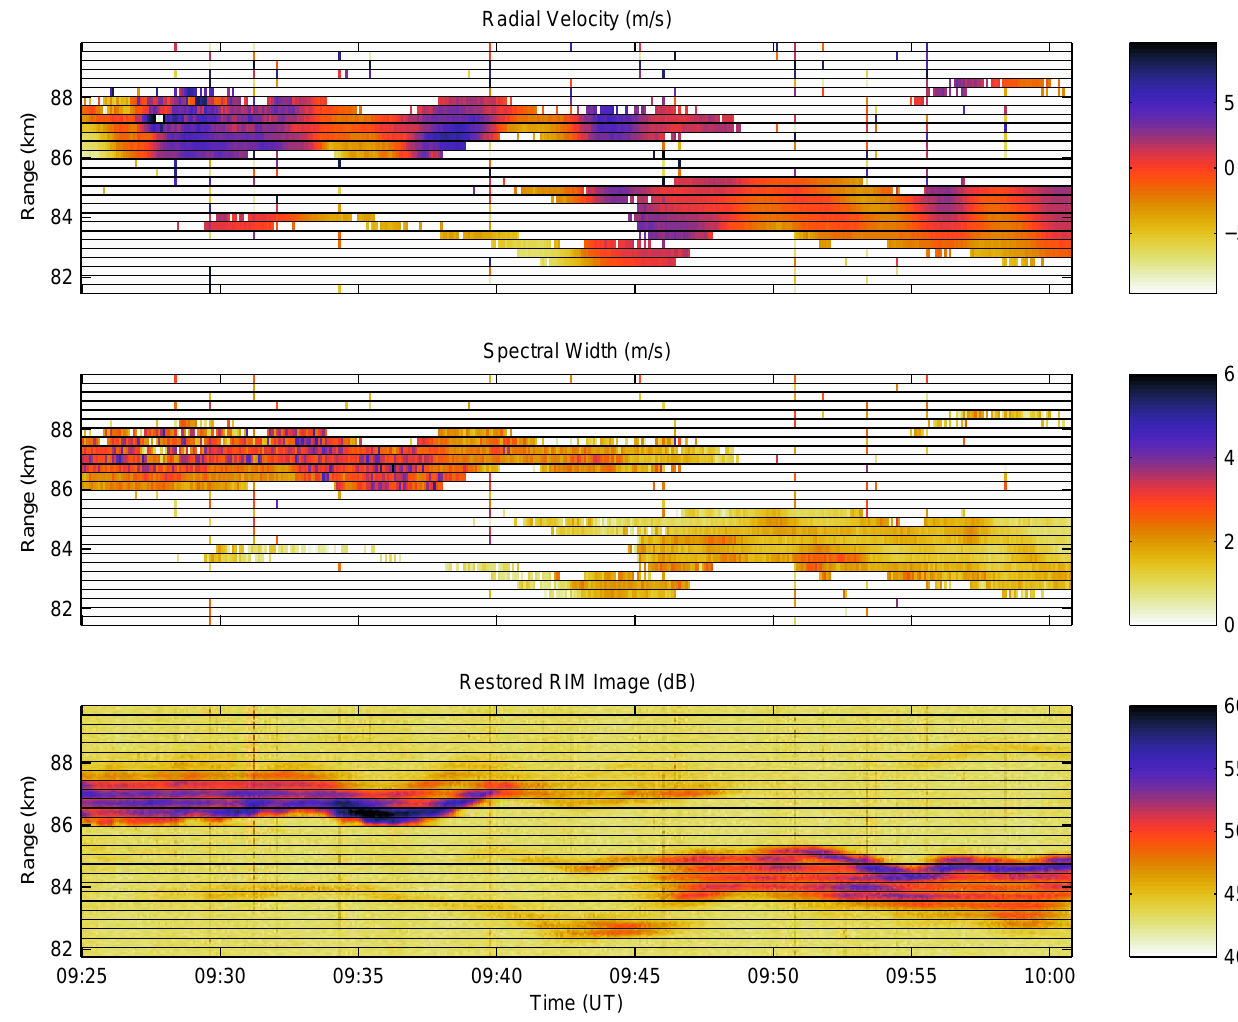
Fig. 11. Radial velocity (vertical), spectral width, and calibrated RIM image for a 35-min period centered at 85km.